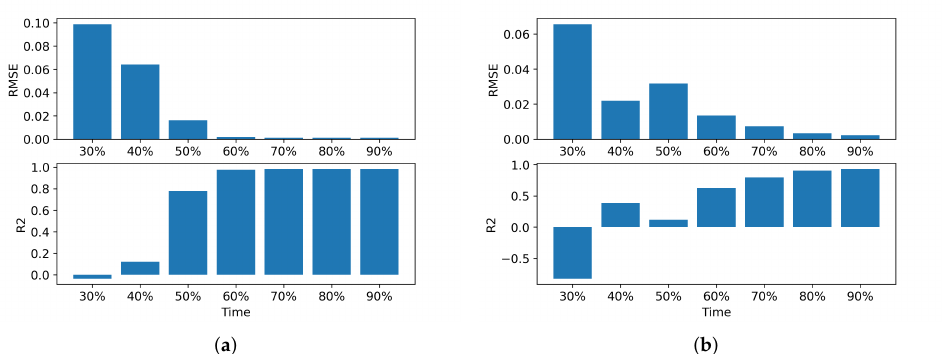
Figure 10. The quantitative comparison results of learned reliability function under different historical data percentages: ( a ) Bearing 1_3; ( b ) Bearing